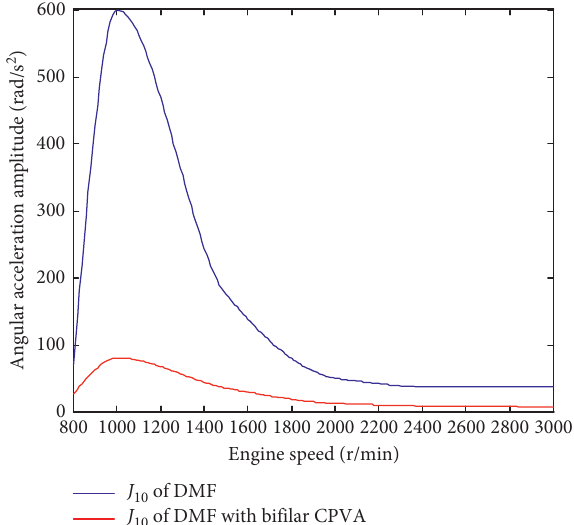
Figure 41: Comparison of the 2 nd order angular acceleration amplitudes of J